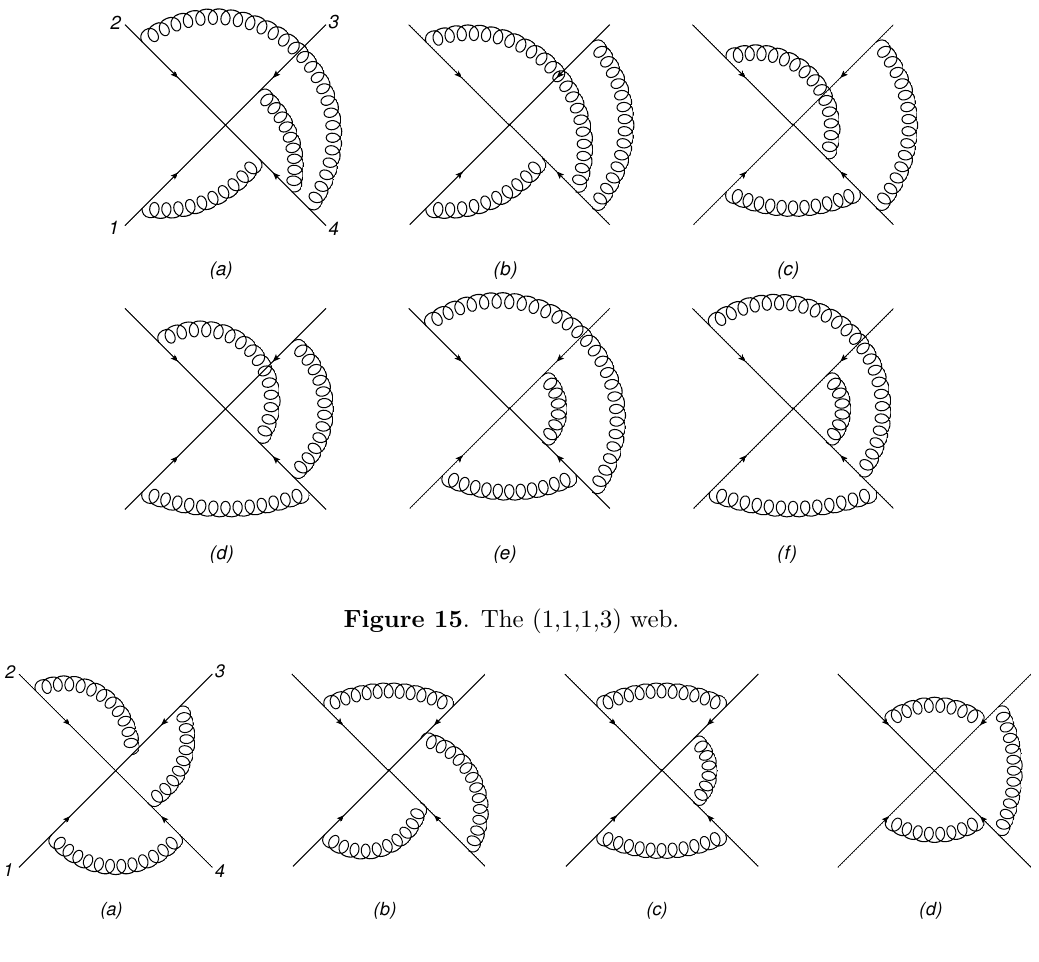
Figure 16 . The (1,1,2,2)